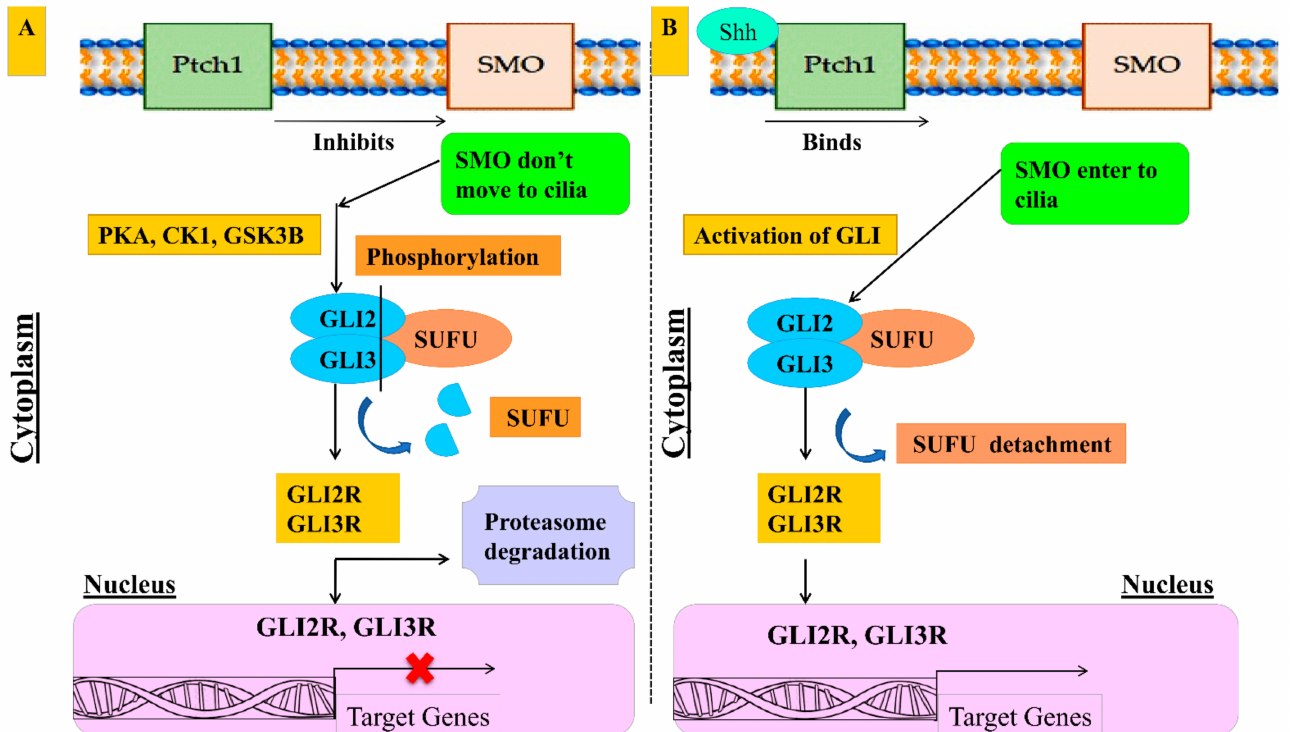
Figure 3. Sonic hedgehog signaling pathway( A ) In the absence of the Shh ligand, Patched-1 (Ptch1) inhibits the Smoothened receptor (SMO), and SMO cannot enter the primary cilium. The phosphory- lation of GLIS can be phosphorylated by the complex of glycogen synthase kinase 3b (GSK3b), protein kinase A (PKA), and casein kinase 1 (CK1). The phosphorylated GLI-2R and GLI-3R were formed into two possible destinations: proteasome degradation and nucleus translocation to suppress the transcription of target genes. ( B ) Hedgehog proteins bind to Ptch1 on the cell surface level, and SMO enters to primary cilium to activate GLI through Suppressor of fused (SUFU) detachment. Then, GLI-2R (mostly) andGLI-3R translocate to the